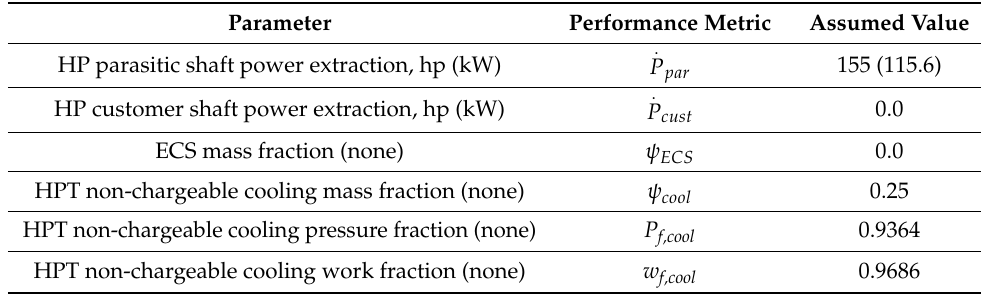
Table 3. DP off-takes and cooling flow